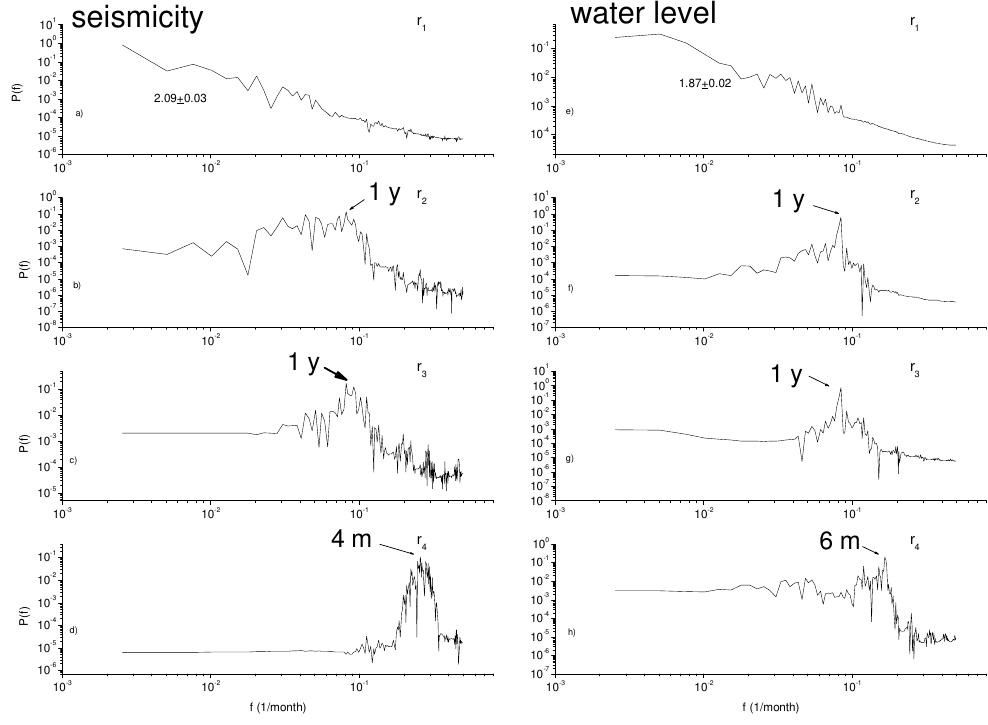
Fig. 7. Power spectrum of the first four reconstructed components shown in Fig. 6.